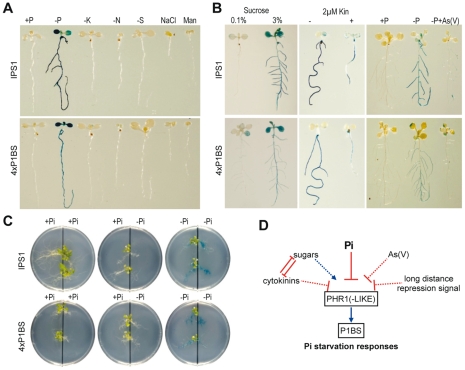
P1BS is an integrator cis motif in Pi starvation signalling.(A–C) Histochemical analysis of GUS activity driven by IPS1:GUS (IPS1) and 4xP1BS:GUS, a reporter gene containing a synthetic promoter harbouring four tandem copies of P1BS fused to the −46 minimal 35S promoter from CaMV (4xP1BS). (A) Response of reporter genes to different types of nutrient starvation stress and to salt and osmotic stress. Plants were grown for 7 days in +Pi or −Pi medium, or media lacking potassium (−K), nitrogen (−N) or sulphur (−S). The effect of saline and osmotic stress was analysed in plants grown for 7 days in complete media supplemented with 150 mM NaCl (NaCl) or 300 mM mannitol (Man), respectively. (B) Response of reporter genes to known agonists (sucrose) or antagonists (cytokinins, arsenate) of the Pi starvation response. To analyse the effect of sucrose, plants were grown for 7 days in +Pi medium in low sucrose (0.1%) and transferred for 3 days to −Pi medium containing two concentrations of sucrose (0.1% or 3%; left). To examine the cytokinin effect, plants were grown for 5 days in −Pi medium, alone or with 2 µM kinetin (Kin; centre). Plants (right) were grown for 7 days in complete liquid medium and transferred for 4 days to +Pi or −Pi media alone or with 30 µM arsenate [As(V)]. (C) Response of reporter genes to long distance repression in a split root assay. Plants were grown for 7 days in complete medium, for 4 additional days on −Pi medium, then transferred for 4 days to split plates with compartments containing +Pi or −Pi media as indicated. (D) Model showing the integrator role of P1BS and consequently PHR1(-like) in Pi starvation signalling.